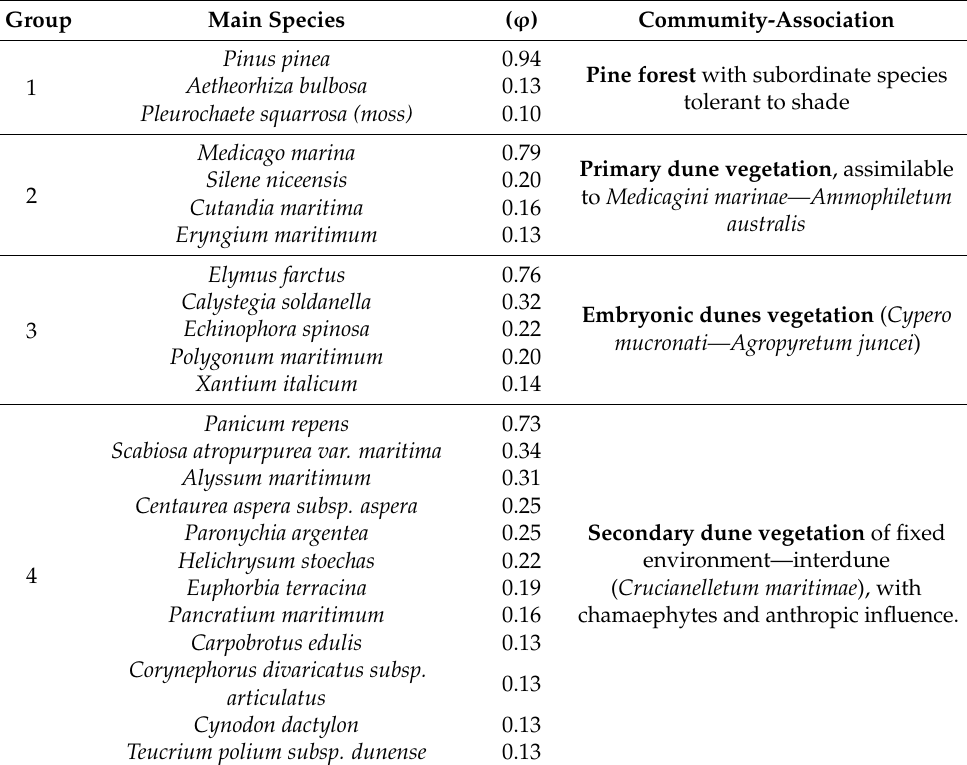
Table 2. Description of the plant community types found. The phytosociological names referenced follow the criteria of Rivas-Martinez et al.